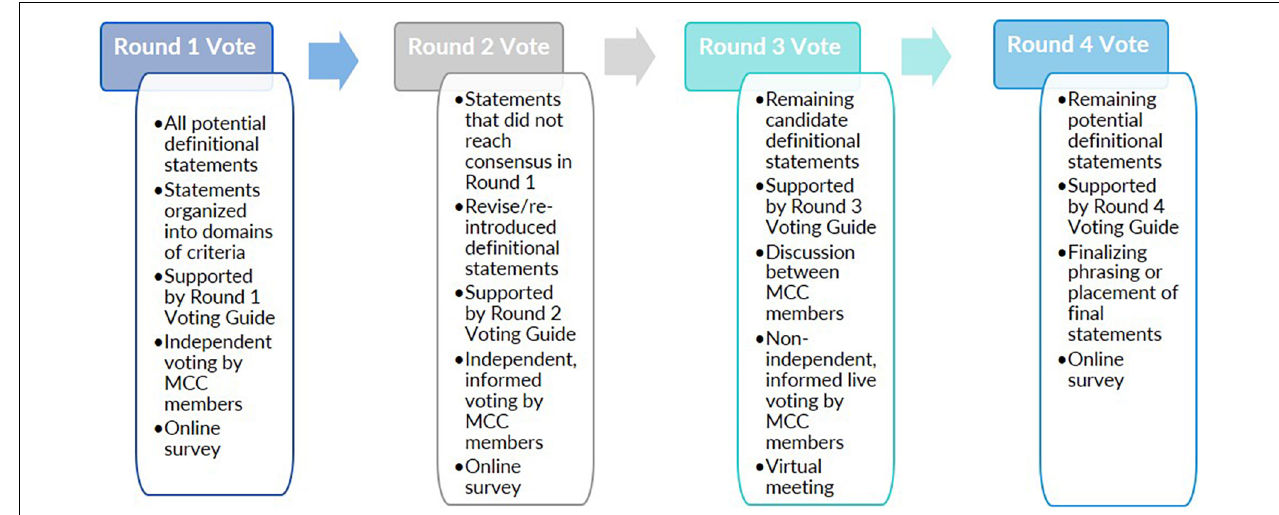
FIGURE 1 | A modified Delphi process was employed to develop a misophonia consensus definition. In four rounds of voting, a Misophonia Consensus Committee (MCC), comprised of subject-matter experts, evaluated potential definitional statements about misophonia. Each round of voting differed in its intended